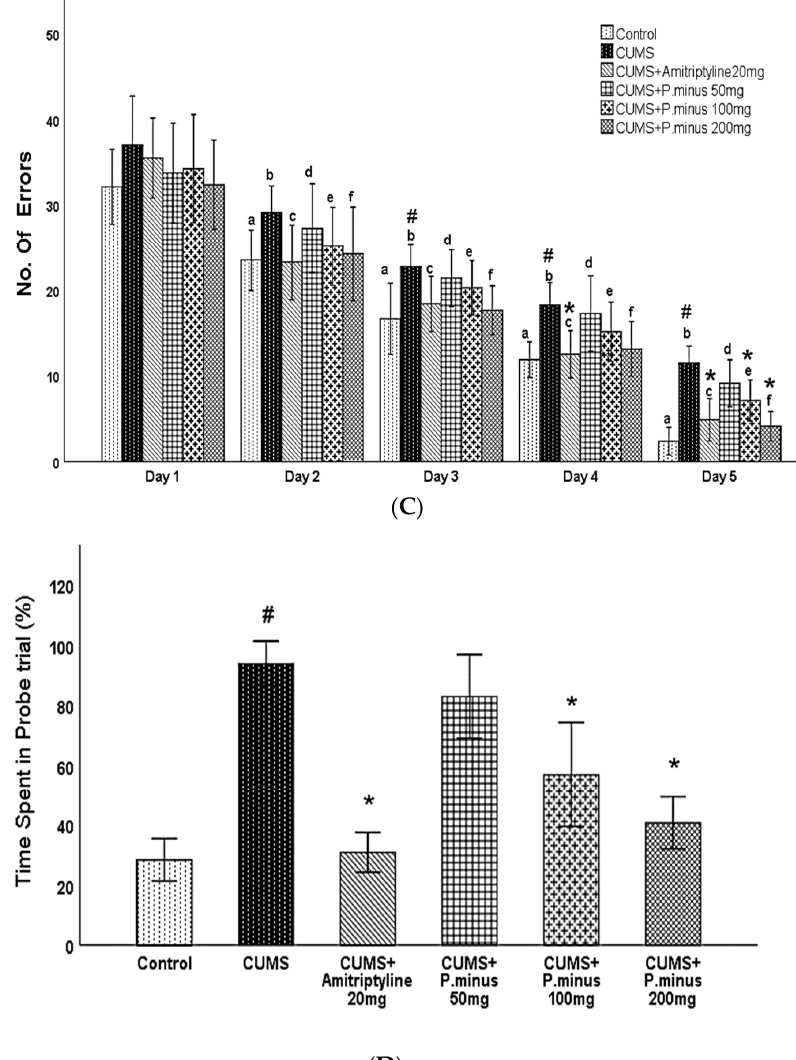
Figure 5. Effects of P. minus aqueous extract on Barnes Maze Assay in CUMS induced depressive mice. ( A )Total distance travelled (cm), ( B ) Latency (sec), ( C ) No of Errors ( D ) Time spent during prob trial # ( p < 0.05), vs. Control group; * ( p < 0.05), vs. CUMS group with respect to each day. CUMS group. a showed significant variance between the Control group (Day 1) and control groups groups. c showed significant variance between CUMS + Amitriptyline20 mg group (Day 1) with between P. minus 50 mg group (Day 1) with other P. minus 50 mg groups on different days. e